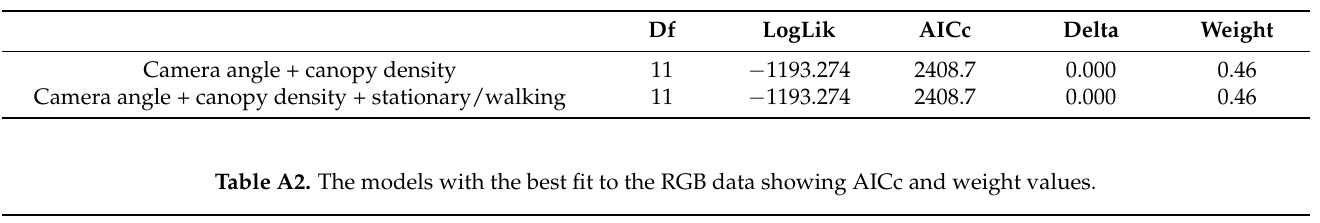
Table A1. The models with the best fit to the TIR data showing AICc and weight values.